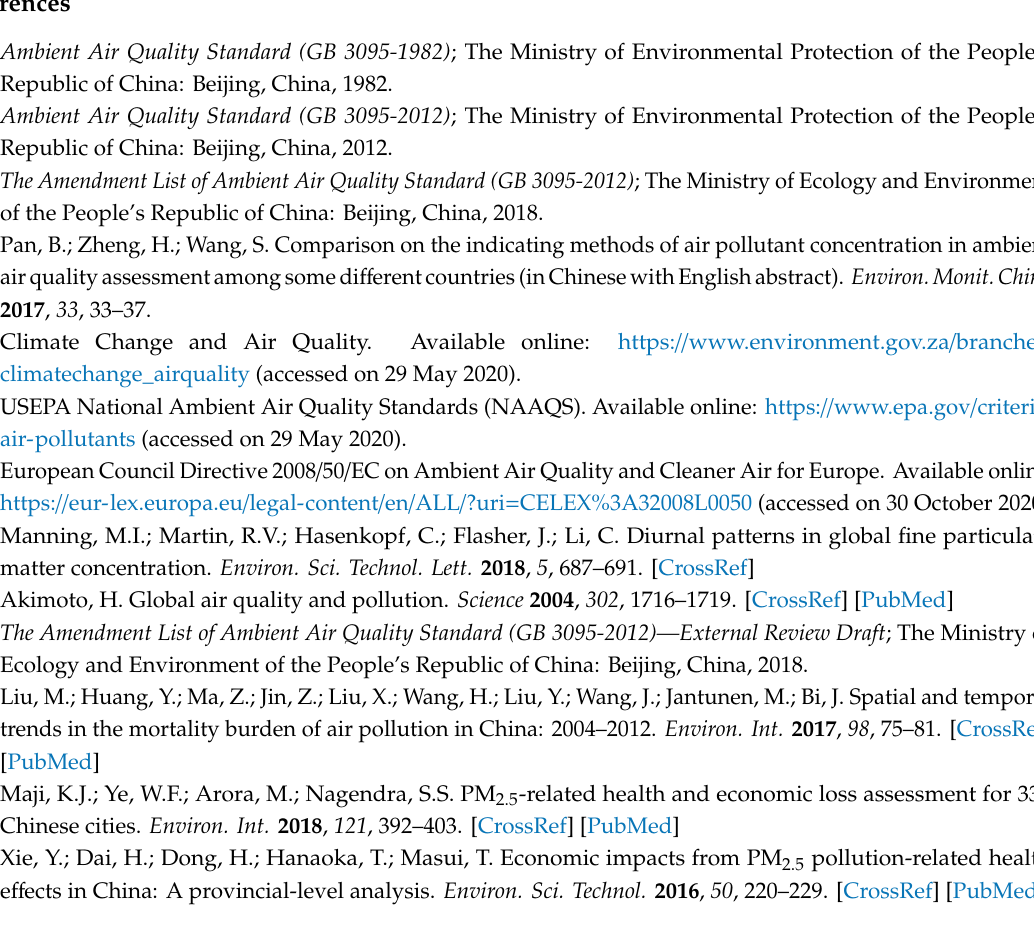
Figure S1: Evolution of pollutant measurement conditions in major countries and regions, Figure S2: National air quality monitoring stations in Mainland China, Figure S3: Meteorological stations in Mainland